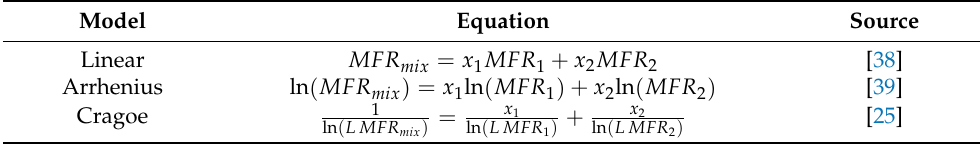
Table 6. Equations of linear, Arrhenius, and Cragoe mixing rules.